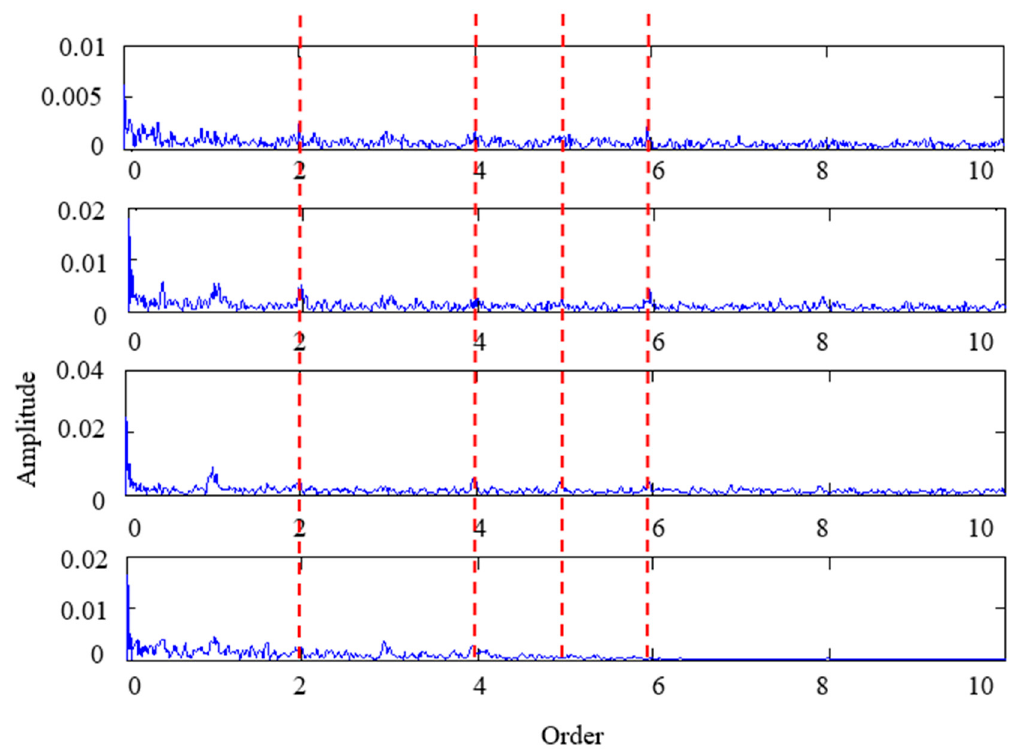
Figure 14. Angle domain waveform of extracted modes for the acoustic signal by empirical wavelet transform (EWT).